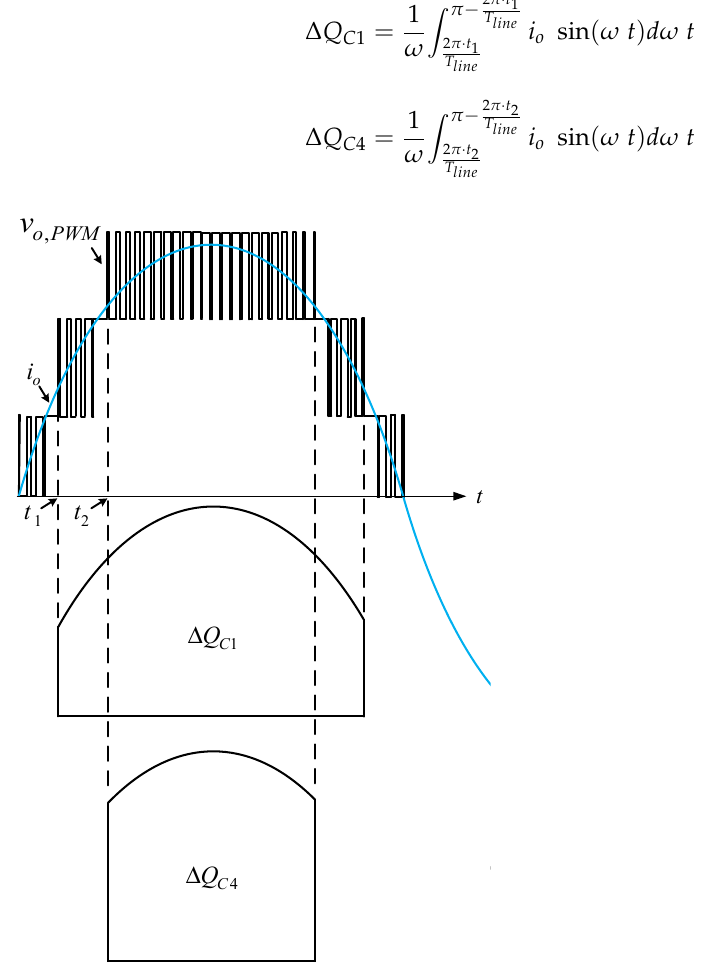
Figure 13. Charge of energy-transferring capacitors C 1 and C 4 during the discharge period.